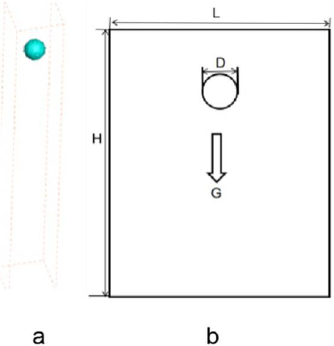
Figure 1. Diagram of a ball falling: ( a ) 3D diagram; ( b ) plane diagram. When the calculation time ∆ t = 3.125 × 10 − 5 s, the maximum Reynolds number is 469.37, which is in good agreement with the results from the studies by Wan [25], Uhlmann [26], and Glowiski [24]. In this paper, the spherical particle is always located on the central axis of the pipe. The spatial discretization scheme is highly symmetrical, and the numerical disturbance caused by the wall resistance is small.